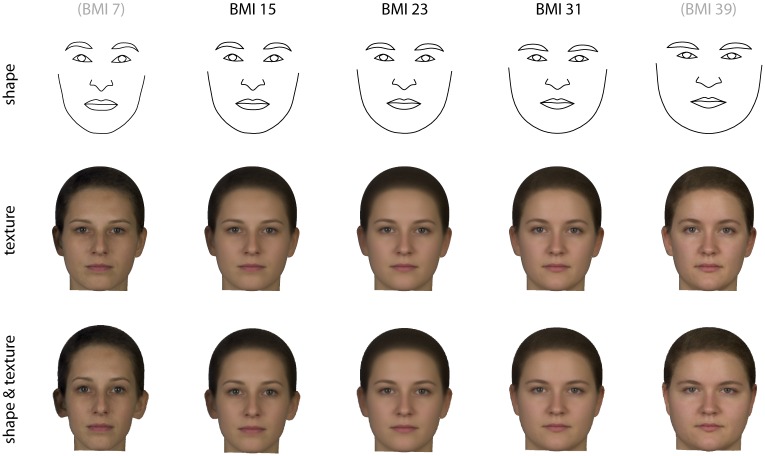
Regressions of shape (upper panel), texture (middle panel), as well as both together (lower panel) on BMI.The reconstructed faces represent the average shapes and textures predicted for BMI 15, 23, and 31, respectively, based on these regressions. These are ±2 standard deviations around the average BMI of 23 and approximately represent the range of variation observed in our sample. The left-most and right-most faces in the figure are twofold extrapolations of this range; they correspond to deviations of ±4 standard deviations from the mean and to (hypothetical) BMIs of 7 and 39.